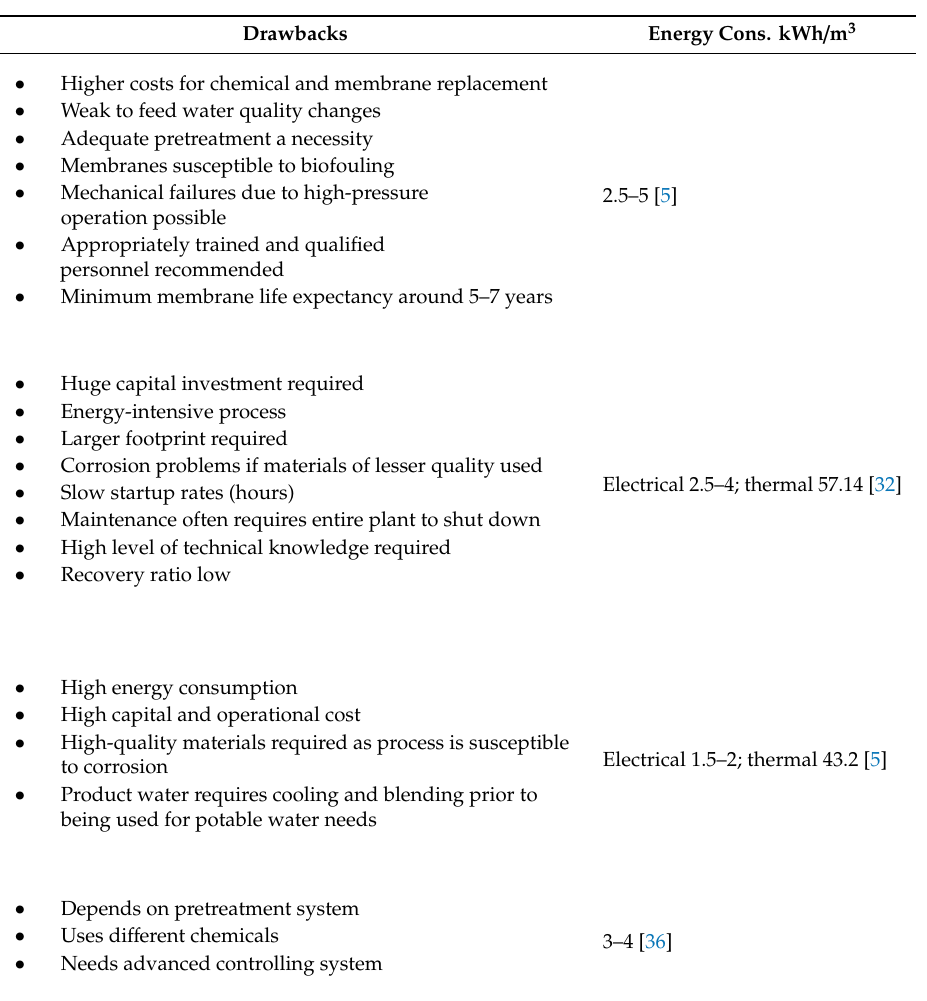
Table 4. Review of advantages and disadvantages of commercialized and emerging desalination